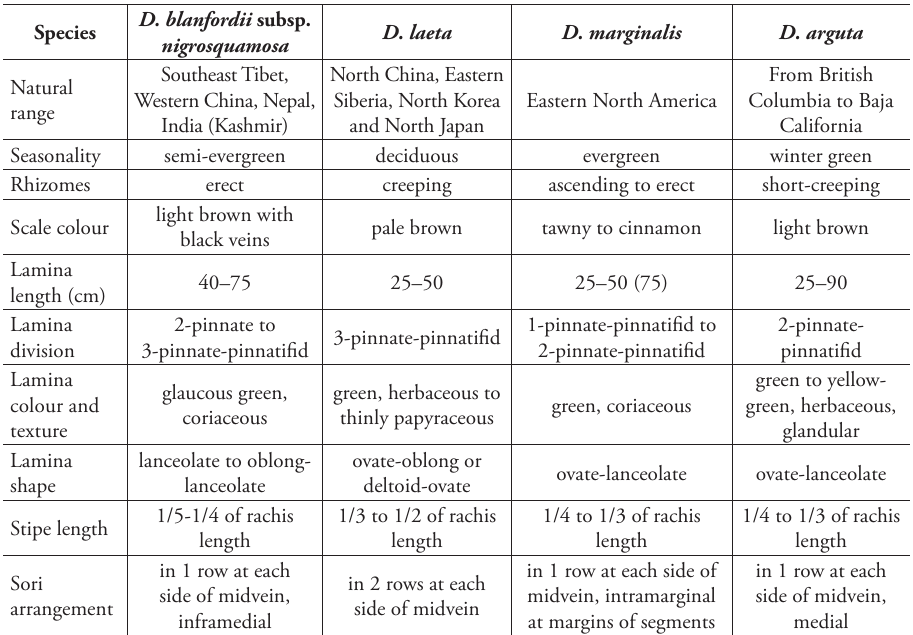
Table 1. Morphological characters of four species of Dryopteris : D. blanfordii subsp. nigrosquamosa , D. laeta , D. marginalis and D. arguta according to Montgomery and Wagner (1993), Mir et al. (2014), Mir et al. (2015). D. blanfordii Species